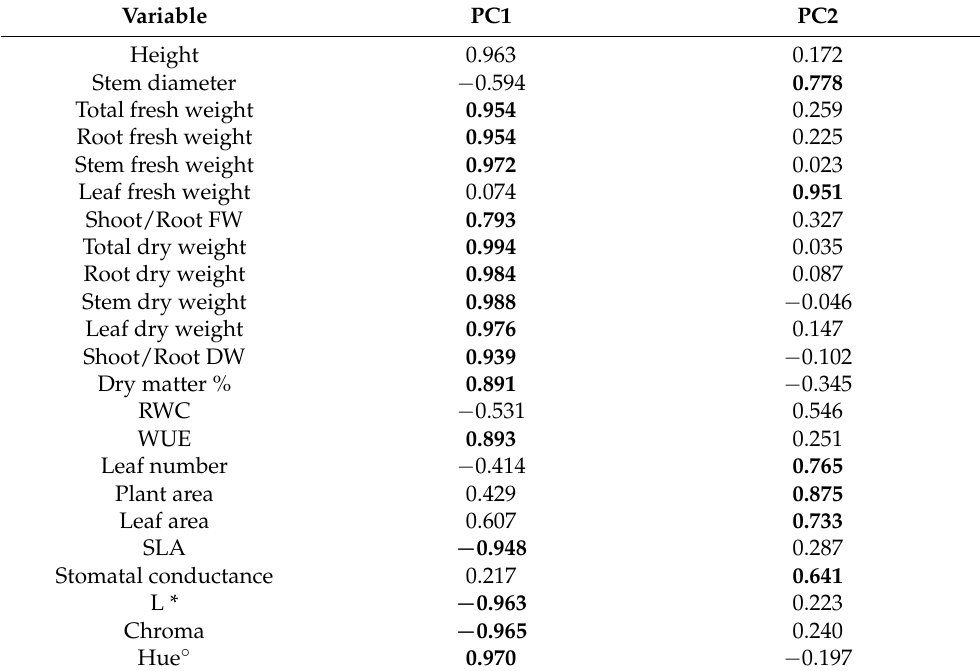
Table 5. Correlation of variables of lettuce and tomato seedlings to the factors of the principal components analysis (PCA) based on factor